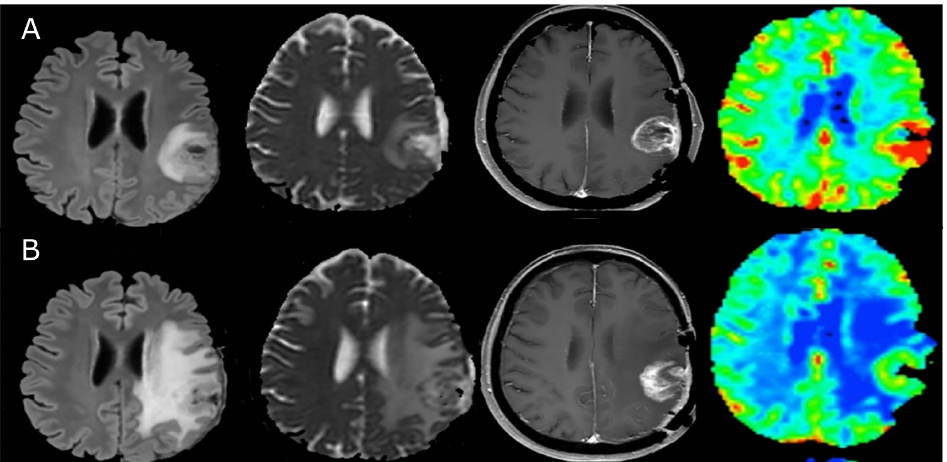
Figure 3. A single subject example of the radiological manifestation of pseudo-progression during immunotherapy, as seen in conventional and advanced MRI. Left to right: FLAIR, ADC, post- gadolinium T 1 , and CBV. In the first MRI scan ( A ) taken after surgery and radio-chemotherapy before immunotherapy initiation, the increased T 1 enhancement and CBV are apparent. An edema is seen in the FLAIR image and decreased ADC, which suggests increased cellularity. In the MRI image set taken four months after immunotherapy ( B ), the tumor volume appears to have increased in the T 1 image, but the CBV has decreased and the ADC values are higher than in ( A ), indicating decreased vascularity and less restriction, respectively. These changes suggest that the apparent increase in tumor volume is actually misleading and is driven by pseudo-progression. Adapted with permission from ref. [89], Cuccarini et al. J. Clin. Med. 2019;8;2007 (CC-BY 4.0